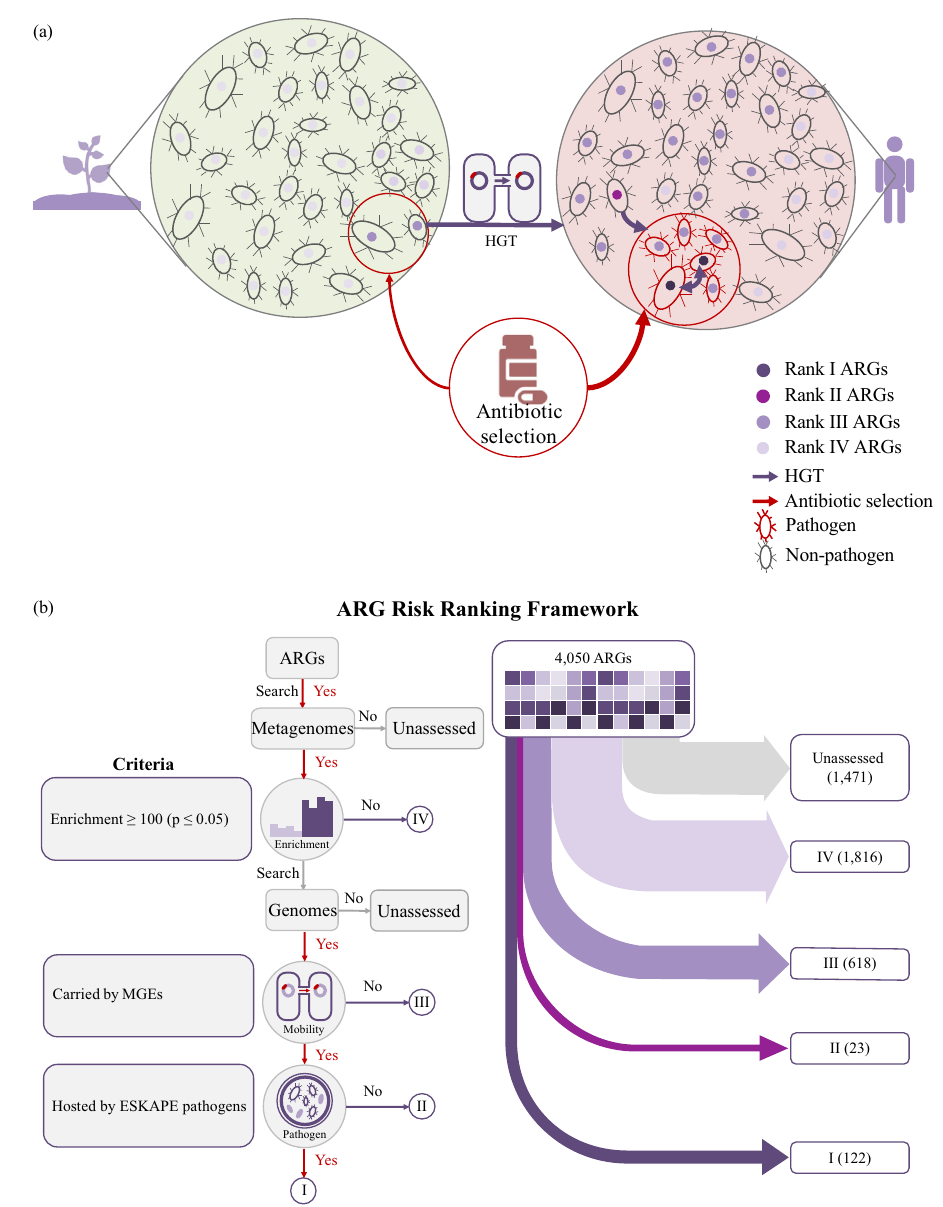
Fig. 2 A conceptual model of the evolution and emergence of antibiotic resistance genes (ARGs) and a framework for assessing ARG risk to human health. a We designed a conceptual model to demonstrate the evolution and emergence of ARGs accelerated by selective agents of antibiotics. b Based on this model, we further designed a framework to re fl ect the natural progression of the evolution and emergence of ARGs and the risk ranks of all ARGs reference sequences of the initial set in the Structured ARG Database v1.0. The color represents the rank of ARGs (Ranks I – IV). The relevant data was obtained by searching the ARGs in all available bacterial genomes and plasmids from NCBI, mobile genetic element (MGE) databases, and 854 global metagenomes using the ARGs Online Searching Platform. HGT horizontal gene transfer, ARGs antibiotic resistance